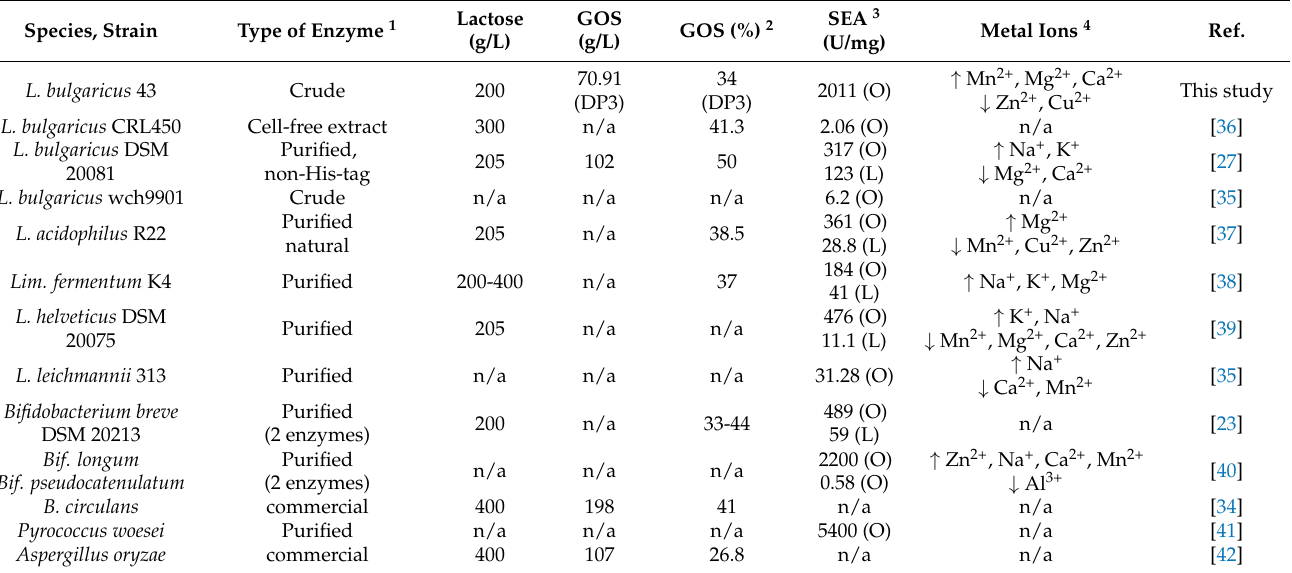
Table 1. Enzyme activity, GOS production, and influence of metal ions on specific enzyme activity (SEA) of selected microbial β